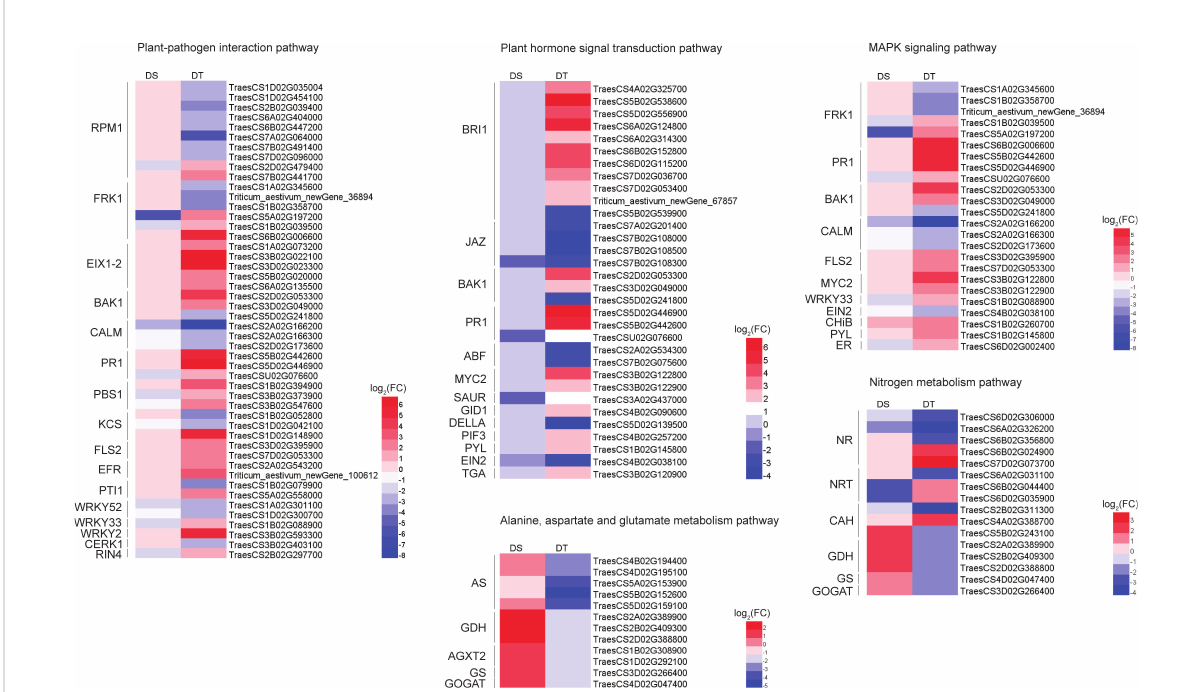
FIGURE 4 Heatmap of the expression of drought-resistant DEGs involved in important pathways. DS, drought-sensitive variety JM38, DT, drought-tolerant variety ZM13, RPM1, disease resistance protein RPM1, FRK1, serine/threonine-protein kinase FRK1, EIX 1-2, ethylene-inducing xylanase receptor, BAK1, brassinosteroid insensitive 1-associated receptor kinase 1, CALM, calmodulins, PR1, pathogenesis-related protein 1, PBS1, serine/ threonine-protein kinase PBS1, KCS, 3-ketoacyl-CoA synthase, FLS2, serine/threonine-protein kinase FLS2, EFR, serine/threonine-protein kinase EFR, PTI1, pto-interacting protein 1, WRKY52, WRKY transcription factor 52, WRKY33, WRKY transcription factor 33, WRKY2, WRKY transcription factor 2, CERK1, chitin elicitor receptor kinase 1, RIN4, RPM1-interacting protein 4, BRI1, brassinosteroid insensitive 1, JAZ, jasmonate ZIM domain-containing protein, ABF, ABA-responsive element binding factor, MYC2, transcription factor MYC2, SAUR, SAUR family protein, GID1, gibberellin receptor GID1, gibberellin receptor GID1, PIF3, phytochrome-interacting factor 3, PYL, abscisic acid receptor PYL, EIN2, ethylene- insensitive protein 2, TGA, transcription factor TGA, CHiB endochitinase B, ER, serine/threonine-protein kinase ERECTA, NR, nitrate reductase, NRT, nitrate transporter, CAH, carbonic anhydrase, GDH, glutamate dehydrogenase, GS, glutamine synthetase, GOGAT, glutamate synthase, AS, Asparagine synthase, AGXT2, alanine-glyoxylate